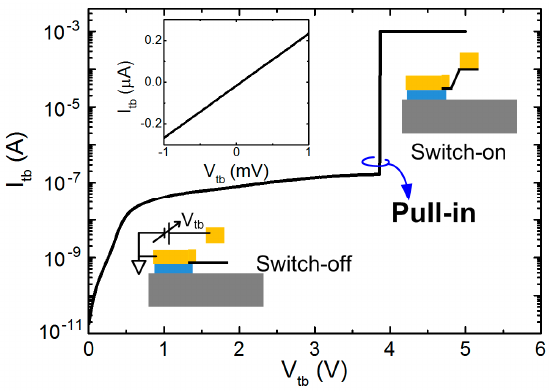
Figure 6. Electrical characterization of the switching performance of a cantilever-type switch. Inset: ( Lower ) two-terminal configuration and switch-off status, ( Right upper ) switch-on status, and ( Left upper ) I-V response after device failure.